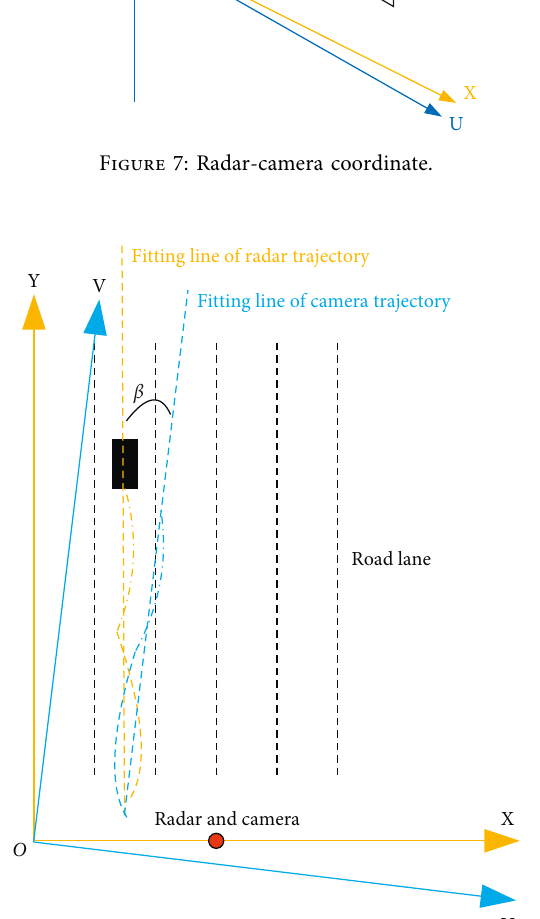
Figure 8: The schematic diagram of azimuth angle calibration between radar and